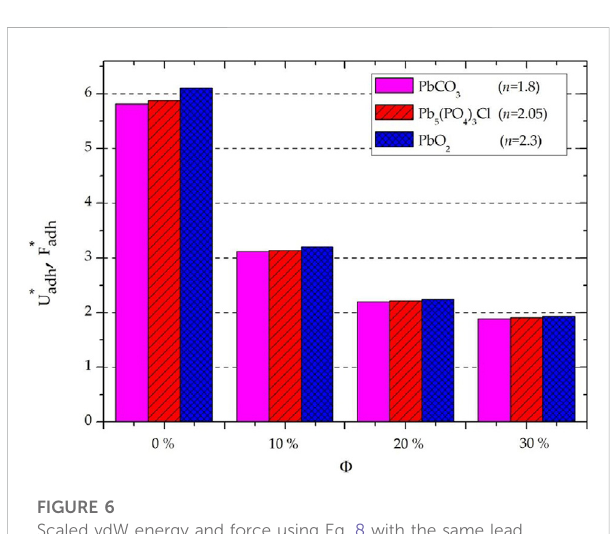
FIGURE 7 Evolution of the scaled energy and force as a function of the refractive index ratio n * considering the lead compounds have the same radius R p =